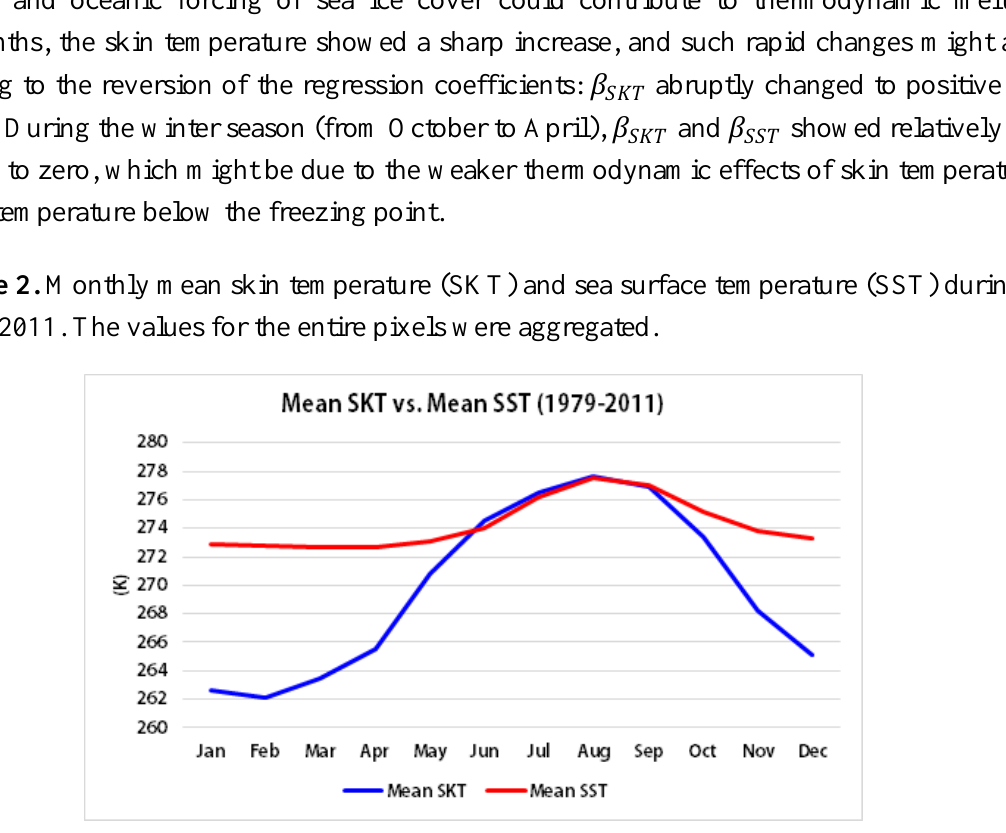
Figure 3. Monthly changes of regression coefficients for skin temperature (SKT) and sea surface temperature (SST). They were calculated from the averages of the normalized variables during